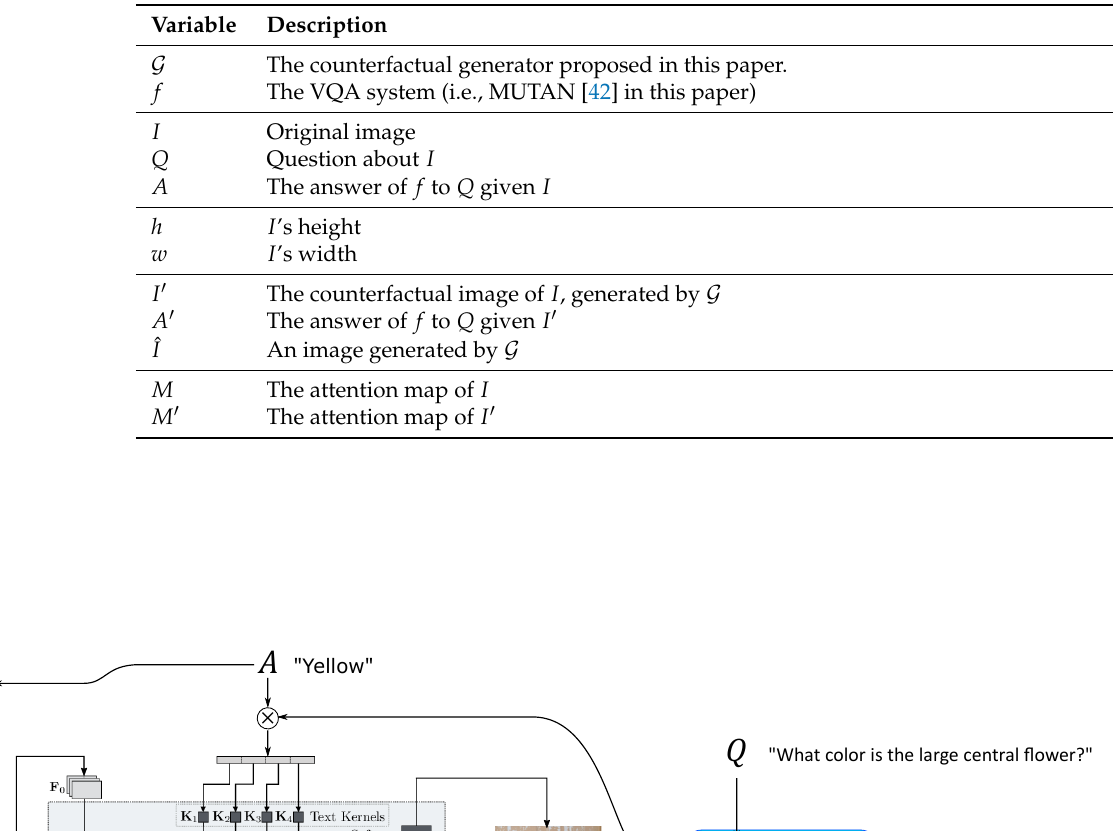
Table 1. Summary of variables used in this paper.